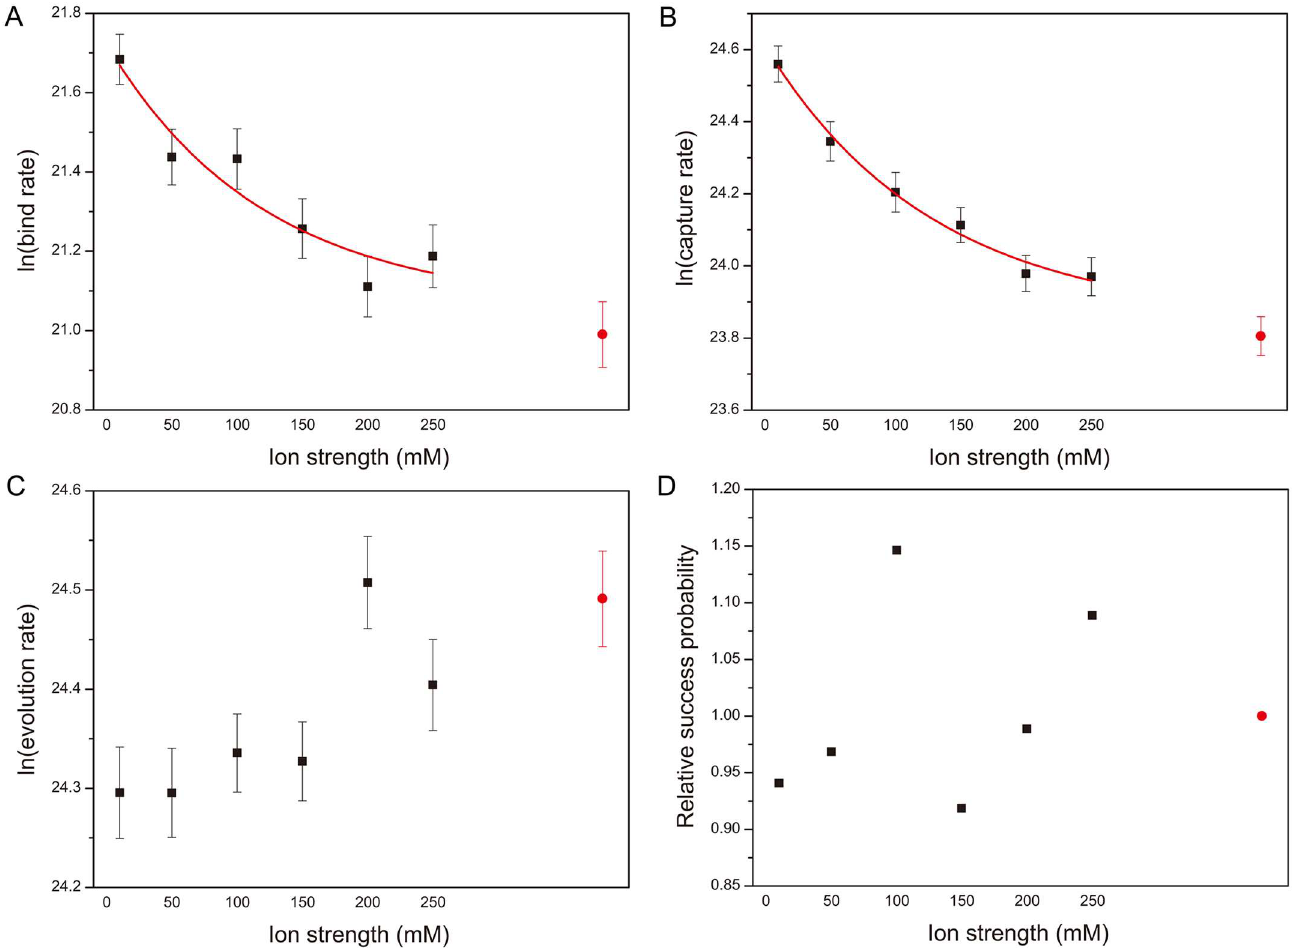
Fig 4. Role of electrostaticinteractions in the binding process. Bindingrate (A) and capture rate (B) for PUMA interacting with Mcl-1 at different ionic strengths dependupon ionic strength, whereascomplexevolutionrate (C) and relativesuccess probabilitythat proceedto bound complex (D) display little or no dependence upon ionic strength. Bind rate, capture rate, and evolutionrate are obtainedby calculatingthe reciprocals of FPT on , MPT cap and FPT evo . All the units of rates are s − 1 . Red data points represent results from simulationsperformed with no chargesincluded.Successful collisionrate is calculatedby mean value of each quotient of bind rate and capture rate. Relativesuccess probabilityis the ratio of successful collision rate with successful collisionobservedwithout electrostatic interactions. Lines to guide the